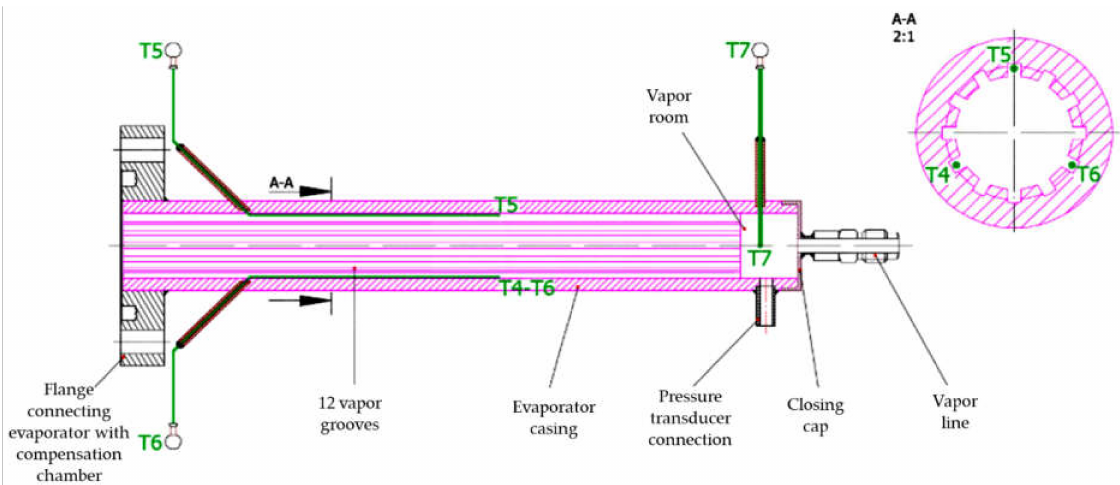
Figure 7. View of the evaporator with connections to thermocouples and pressure